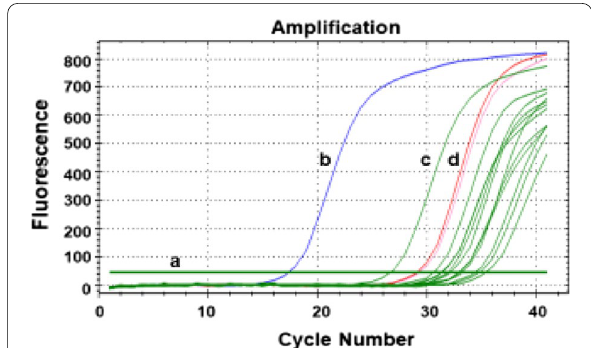
Fig. 1 Comparative quantification of mRNA expression expressed as